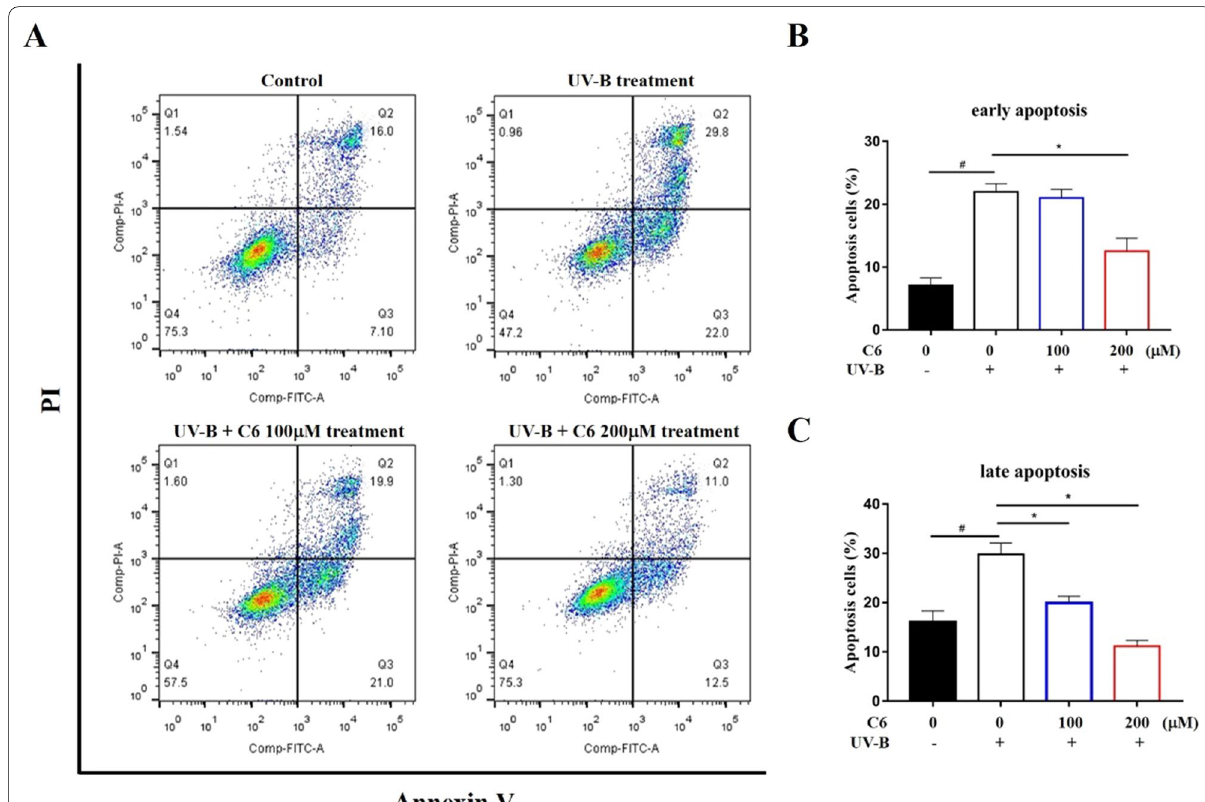
Fig. 3 Bibenzyl derivatives in D. officinale reduce the cell apoptosis. A Typical flow charts determinate by Annexin V/PI double staining. The necrotic cells were identified as Annexin V /PI (Q1), C late apoptotic cells as Annexin V − + cells as Annexin V /PI (Q4). # P < 0.05, significantly different from control group; *P < 0.05, significantly different from model − −